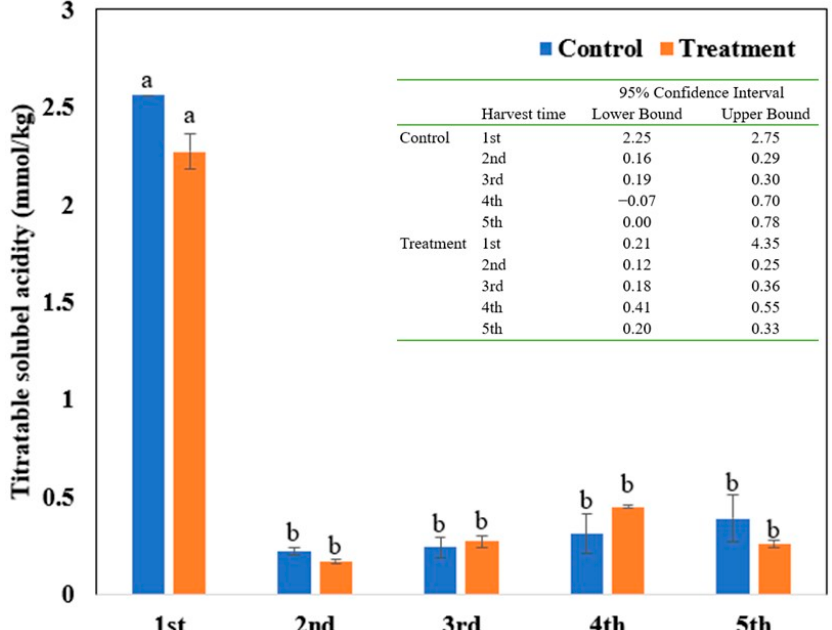
Figure 1. Temporal variation in soil titratable acidity in the control and the treatment. The data are presented as mean ± standard error (n = 3) with different letters above the bars for either the control or the treatment indicating significant differences at p < 0.05. The 95% confidence intervals for different harvest cycles in the control and the treatment are also provided.